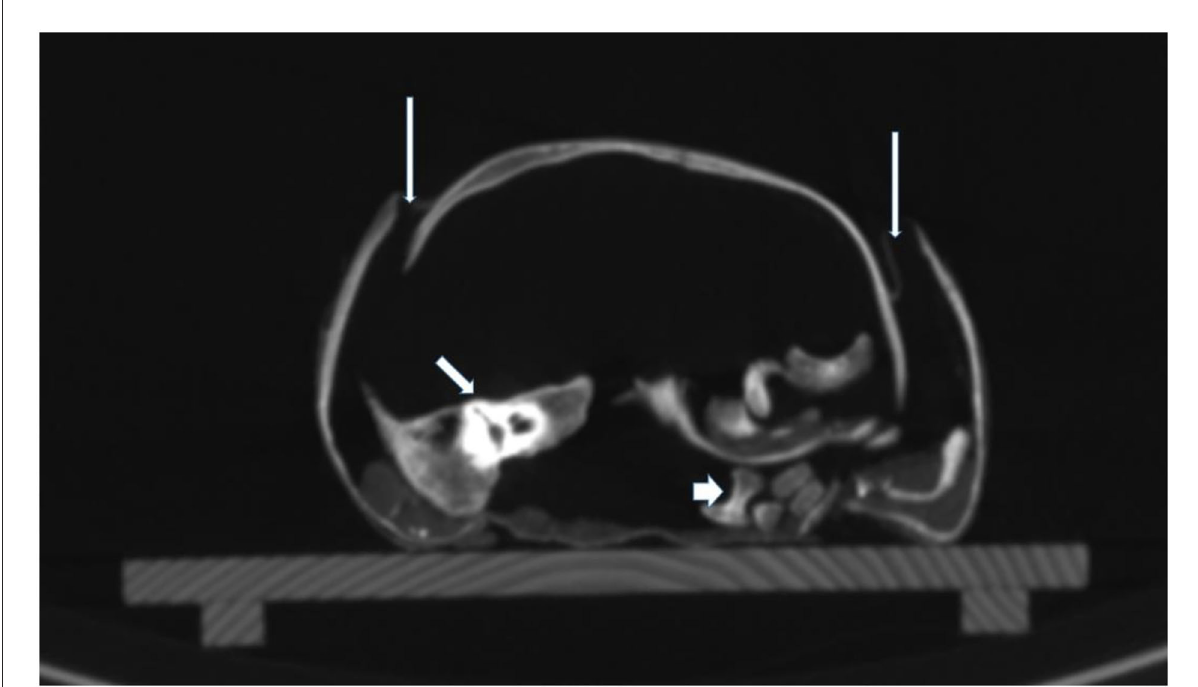
FIGURE7 CT scan of the skull base. On cross-sections, the extensive dislocation of the bones of the skull base is visible. Thin arrows: disruption of sutures; middle arrow: dislocated right petrous bone; thick arrow: dislocated parts of vertebral bodies.